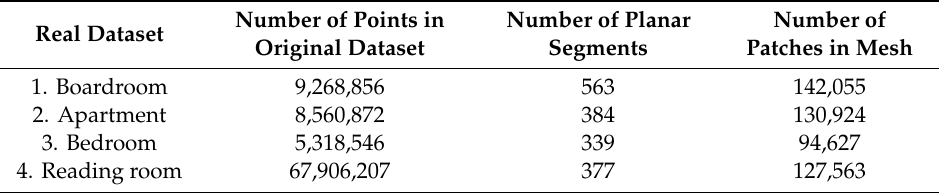
Table 2. Statistical indicators of four real